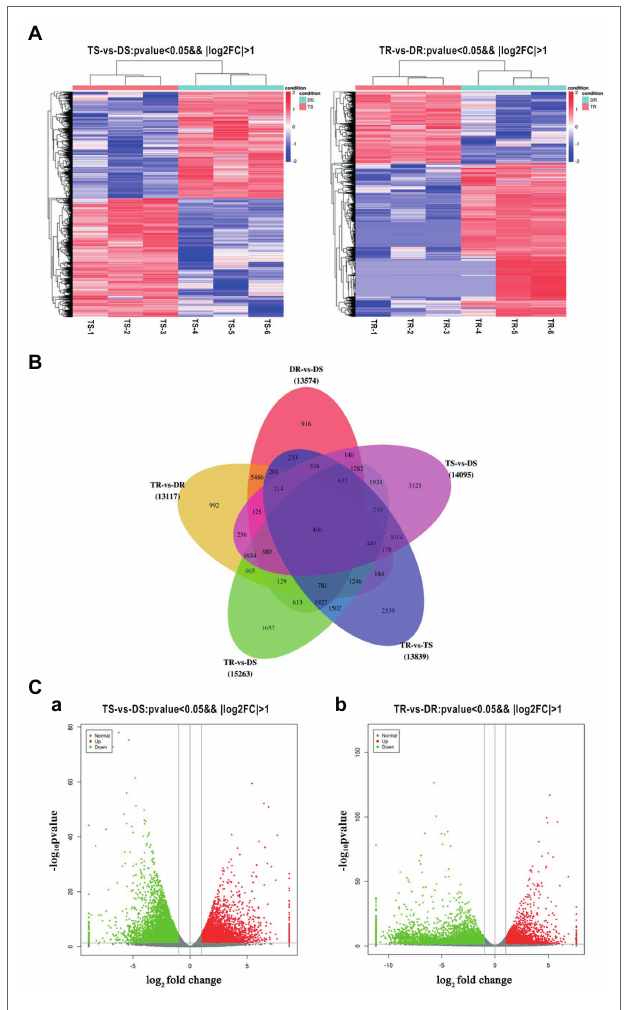
FIGURE 4 | (A) Heatmap of DEG expression profiles (RNA-Seq) in tetraploid vs. diploid shoots. Left: DEGs were derived from TS-1_TS-2_ TS-3_vs DS-1_ DS-2_ DS-3. Right: DEGs were derived from TR-1_ TR-2_ TR-3_vs DR-1_ DR-2_ DR-3. Thresholds for DEG selection in the heatmap are p < 0.05 and |log 2 FoldChange| > 2. (B) Venn diagram analysis comparing five groups of DEGs. (C) Volcano plot of DEGs. a,b Represent the number of DEGs that were up- or downregulated for TS vs. DS and TR vs. DR, respectively. Grey indicates unigenes with similar expression patterns, red indicates significantly upregulated unigenes, and green indicates significantly downregulated unigenes. The x-axis is the log 2 FoldChange, and the y-axis is the log 10 P